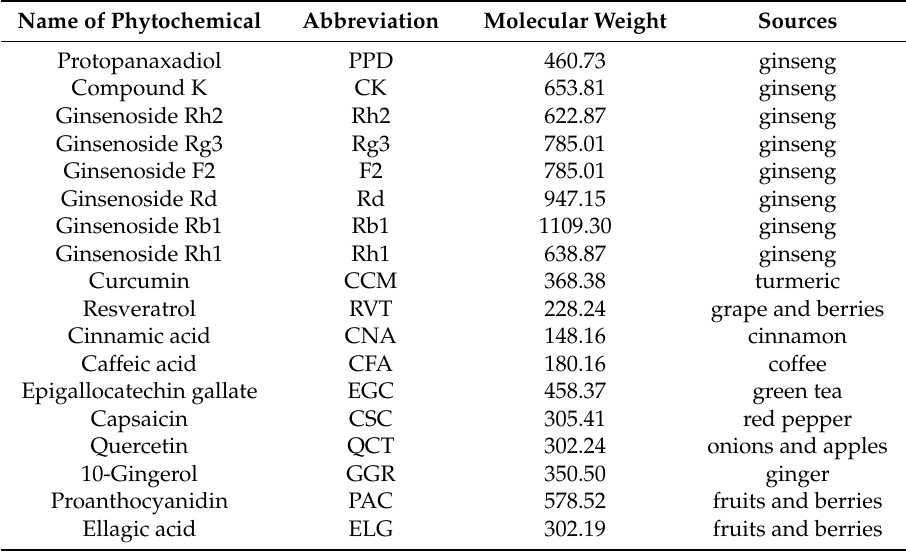
Table A1. List of phytochemicals tested for anti-noroviral